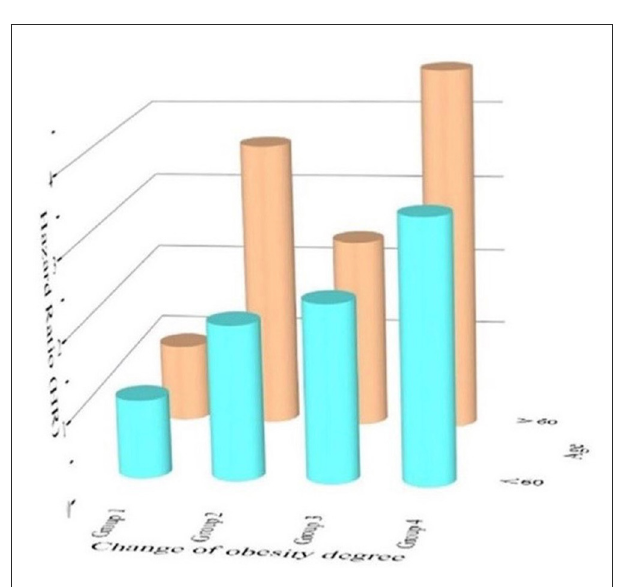
FIGURE6 3D bar plot showing the cox regression analysis of age under 60 years old and age over 60 years